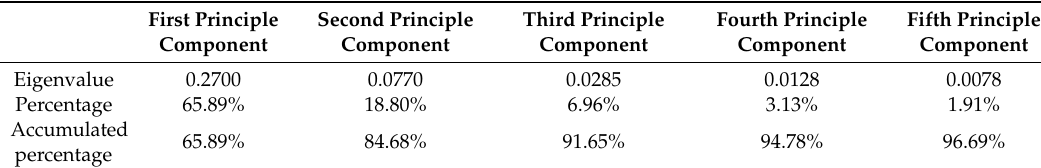
Table 5. Features reduction by PCA.